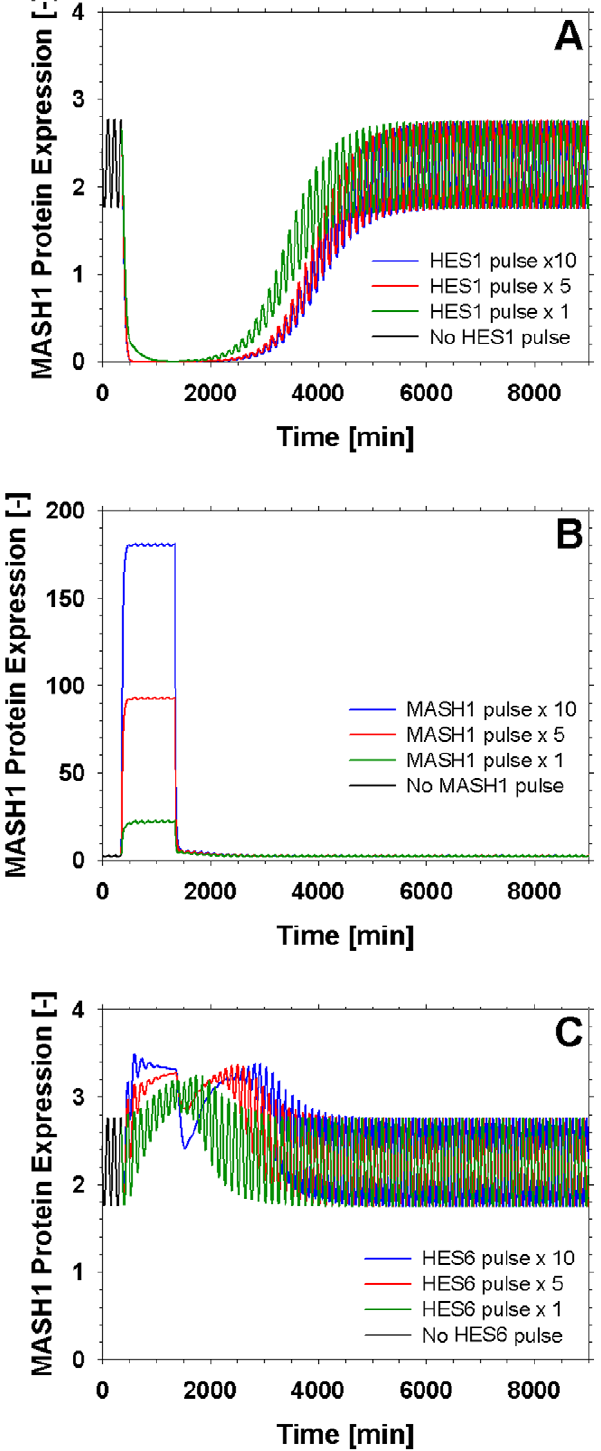
Figure 6. Response of Mash1 expression to the application of variably sized pulses ( 6 1, 6 5, 6 10) for a fixed time period (980min). The pulse was applied through a constant generation term in the right hand side of the equations describing cytoplasmic Hes1 (A), Mash1 (B) and Hes6 (C) concentrations respectively.